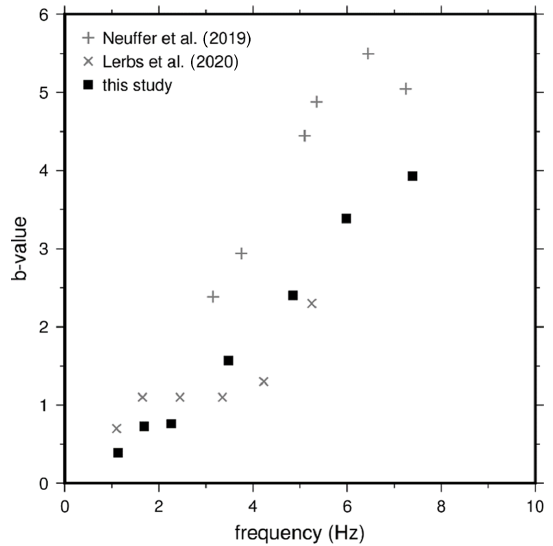
Figure 5. Frequency dependence of b values for peak 1 to peak 7 (filled symbols, cf. Fig. 4). Plus signs and crosses mark calculated b values of Neuffer et al. (2019) and Lerbs et al. (2020), respec-